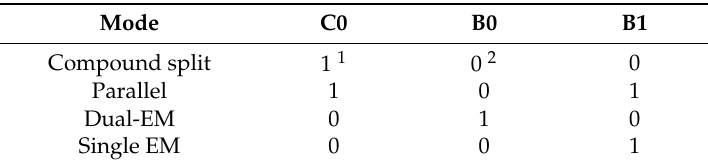
Table 1. Operating modes of the MMPS powertrain.